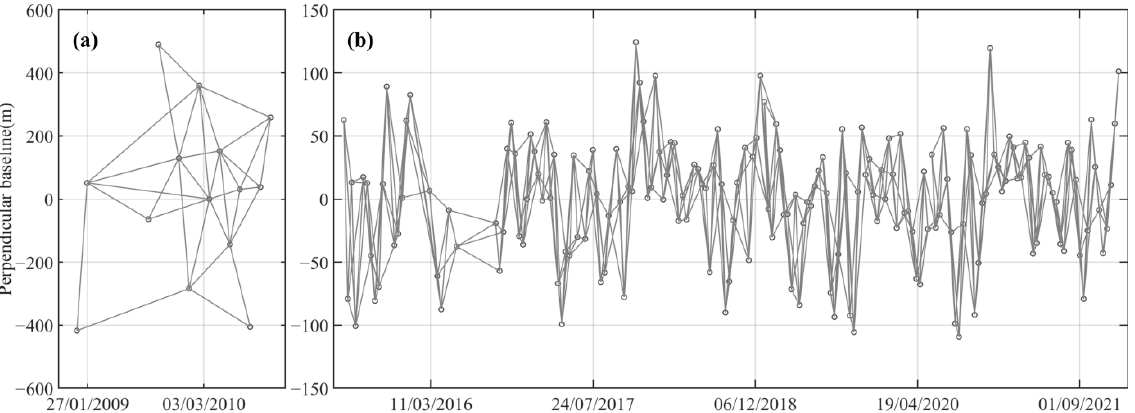
Figure 2. Temporal/perpendicular baselines of ( a ) Envisat/ASAR and ( b ) Sentinel-1A interferometric pairs.